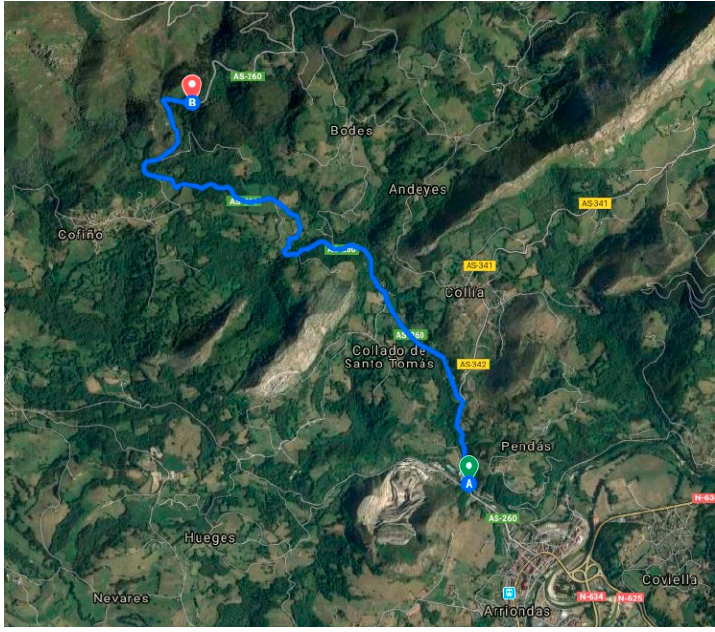
Figure 7. Map of the track.